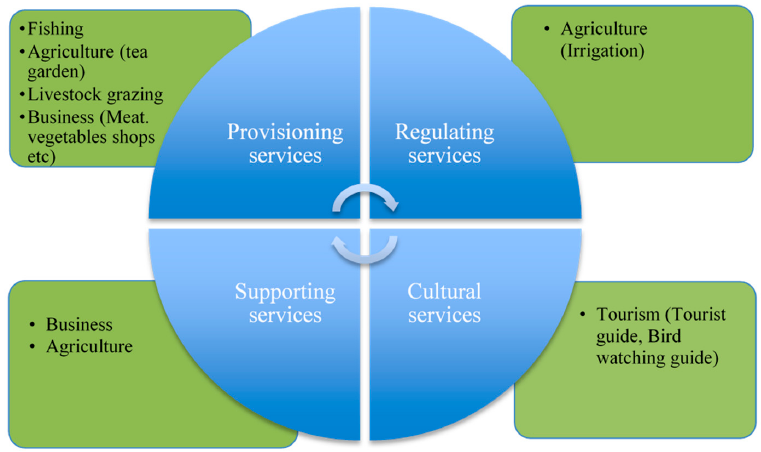
Figure 3. Livelihood strategies and their links to four categories of ecosystem services in Maguri- Motapung Beel (adapted from Sandhu and Sandhu, 2014).